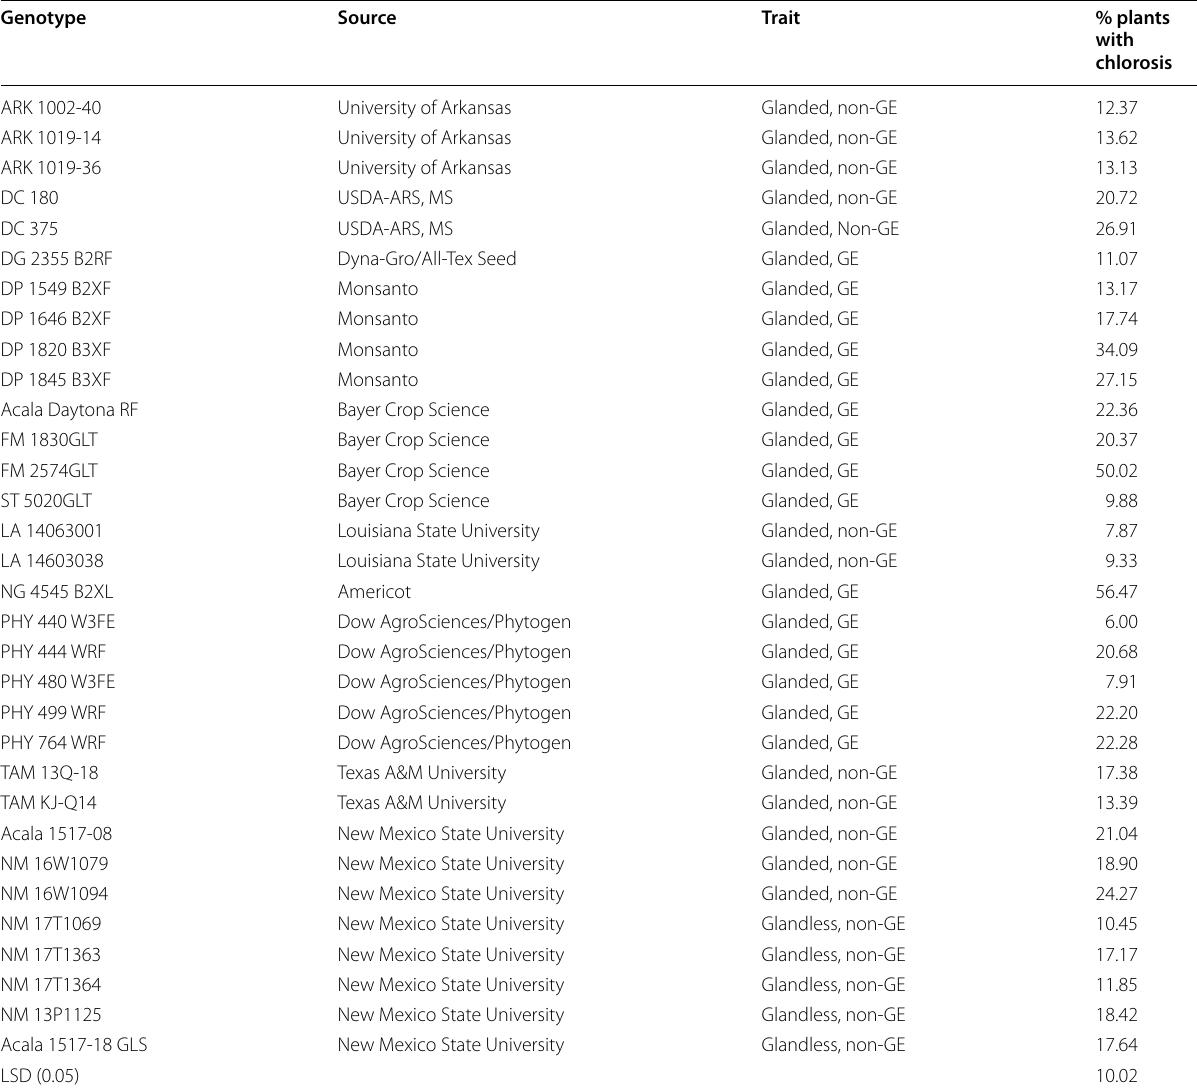
Table 6 Mean crop injury rating caused by herbicide trifloxysulfuron in test 18HQ with 32 Upland cotton genotypes, Las Cruces,